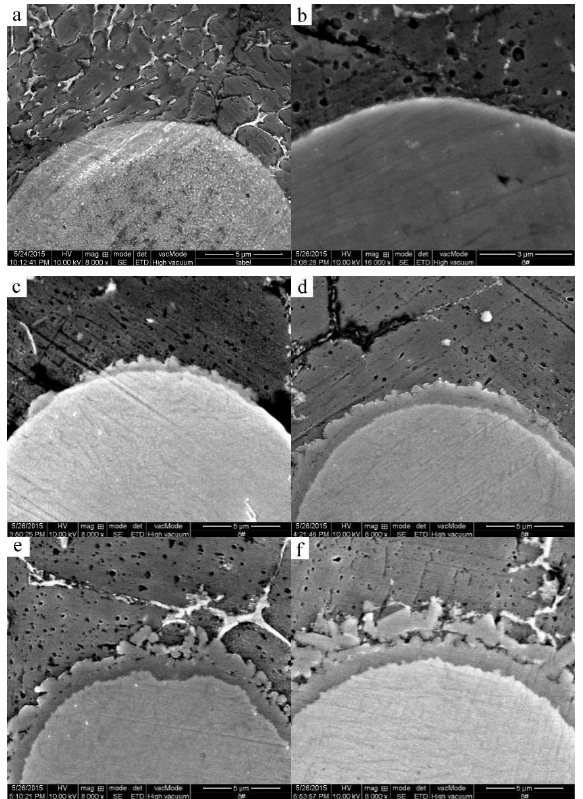
Figure 9. High magnification SEM micrographs of the mixed powder bulk heated at 640 °C for different times. ( a ) 0 min; ( b ) 5 min; ( c ) 10 min; ( d ) 15 min; ( e ) 25 min; ( f ) 45 min.